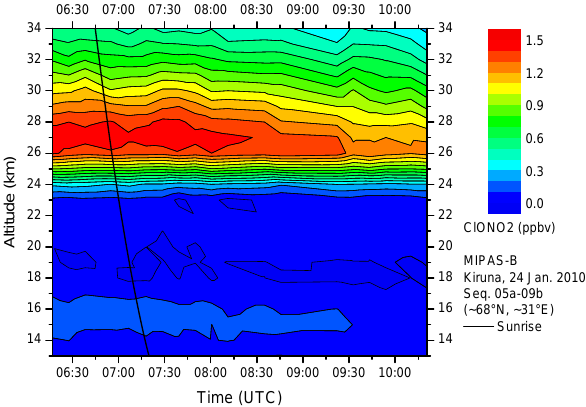
Fig. 7. Simulation of the chlorine monoxide dimer ClOOCl at the MIPAS-B measurement locations. The photodissociation starts at sunrise. For details, see text.